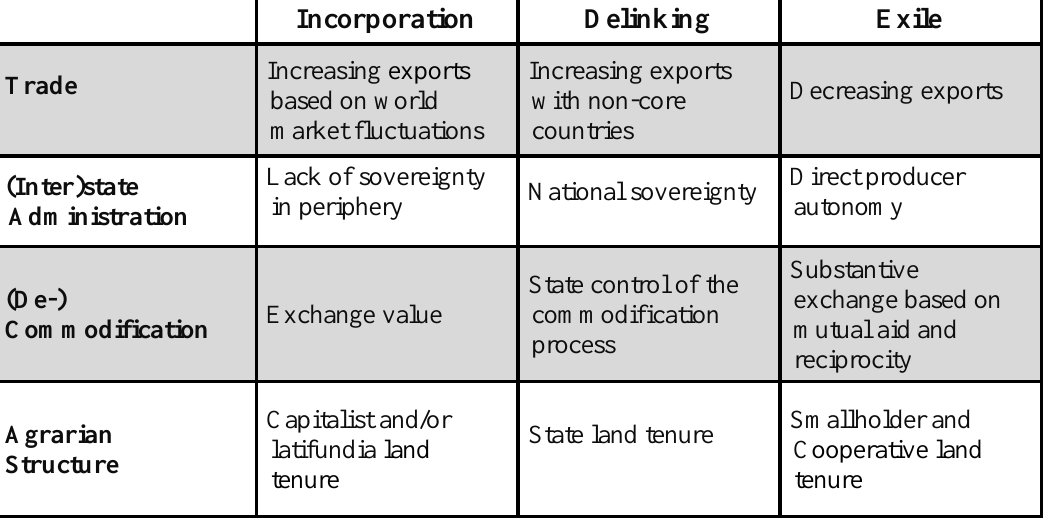
Table 2. Components of Nominal Measurement for Structural